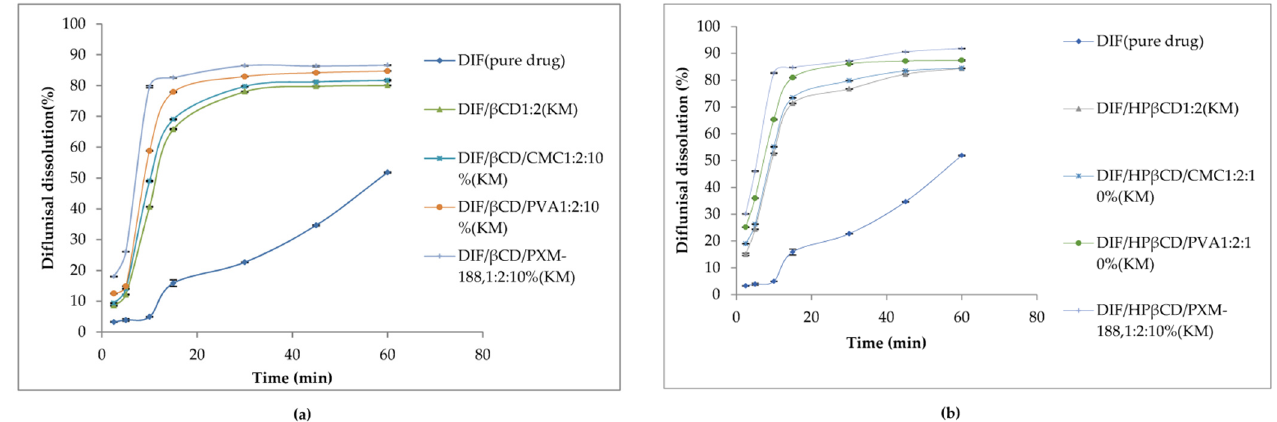
Figure 10. Dissolution profiles of diflunisal, and cyclodextrin inclusion complexes with β -cyclodextrin ( a ) and hydrox- ypropyl β -cyclodextrin ( b ). DIF—diflunisal; β -CD— β -cyclodextrin; HP β -CD—hydroxypropyl β -cyclodextrin; CMC— carboxymethyl cellulose sodium; PVA—polyvinyl alcohol; PXM-188—poloxamer-188. Reproduced from [46], with permis- sion from MDPI, 2021.